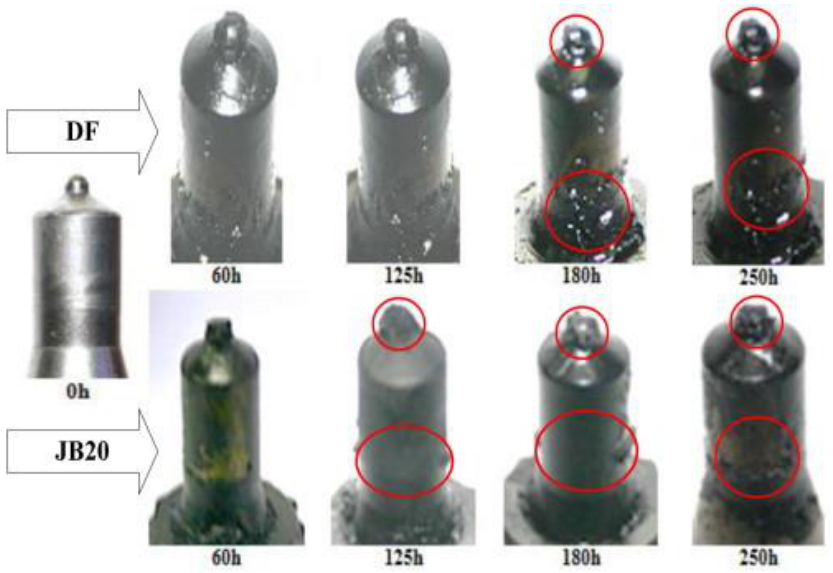
Figure 8. Image of Injector Nozzle showing carbon deposition (red circle) during an endurance Test